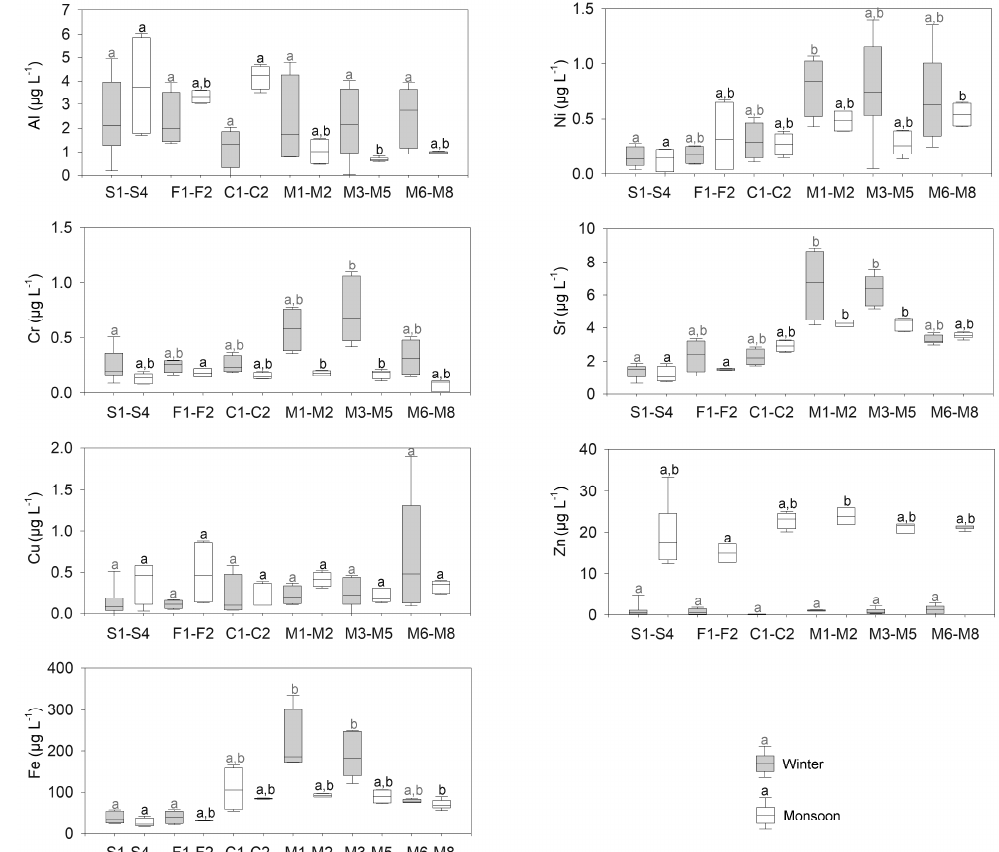
Figure 5. Comparison of trace metals concentration in surface water during winter and monsoon seasons for the Nongkrem and Umiew nested catchments system. The line within the box represents the median the inter quartile range, while whiskers show the minimum and maximum values. Variables with the different letters (a, b, c) are significantly different among sites within each season with p < 0.05 (based on Kruskal-Wallis test).